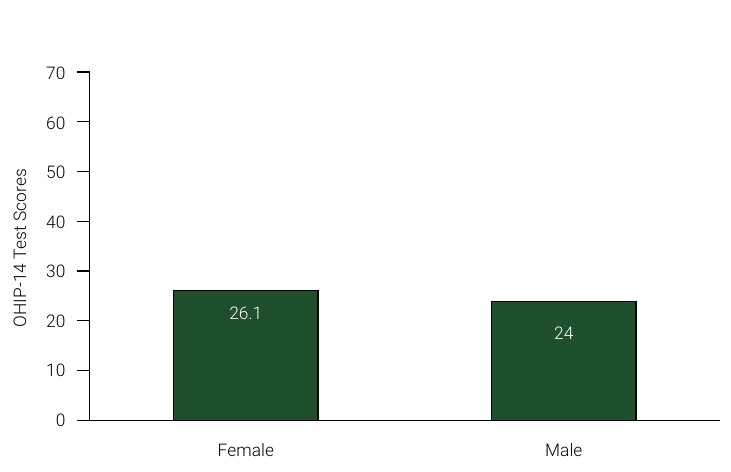
Figure 4. Relationship between gender and OHIP-14 test scores.